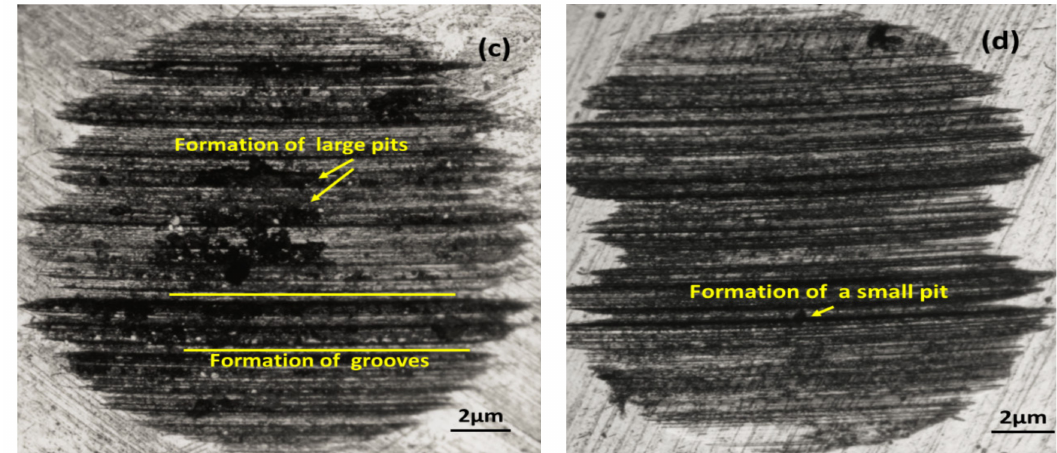
Figure 4. Optical microscopy pictographs of the wear scars on the balls with ( a ) MO, ( b ) 2% WS 2 , ( c ) 3% MoS 2 and ( d ) 3% PT.